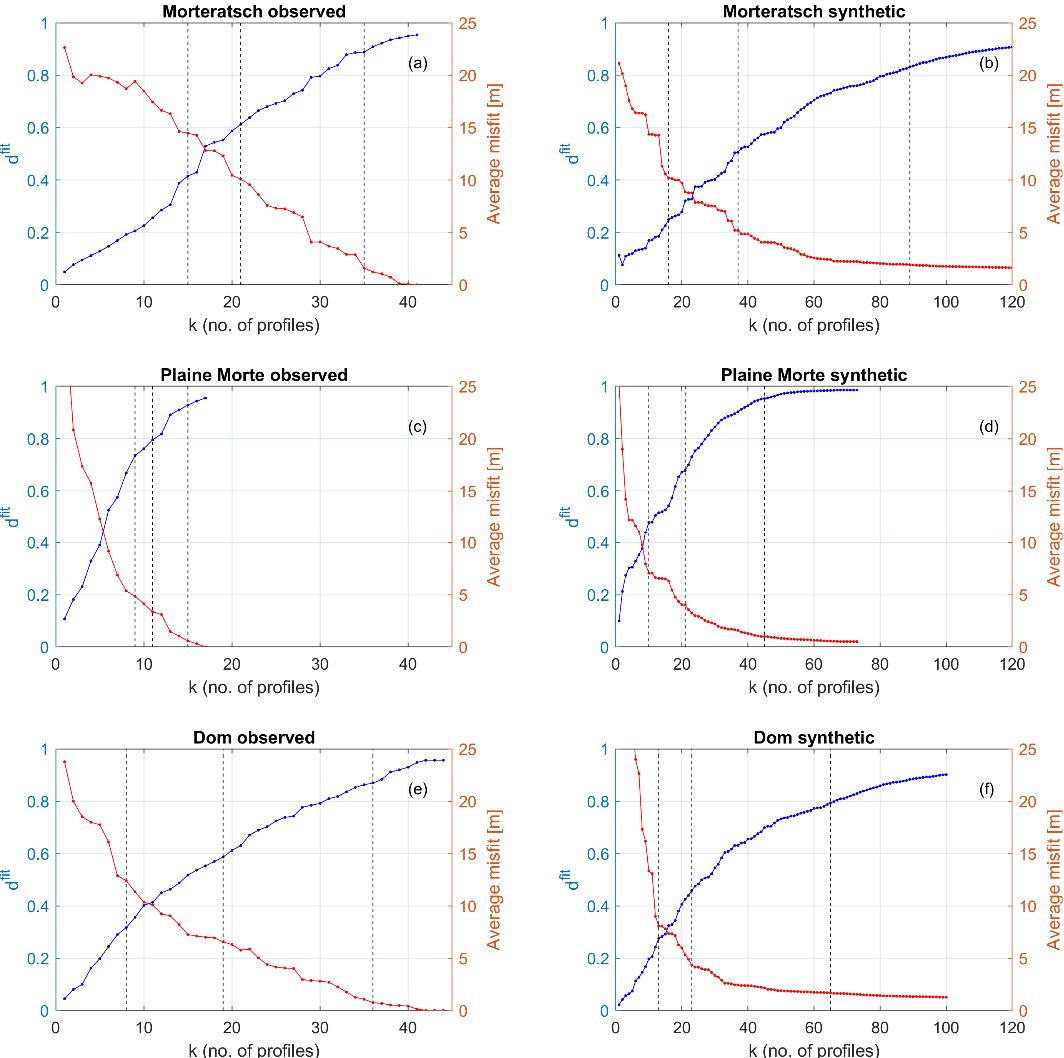
Figure 5. Evolution of data fit d fit (blue curves) and average data misfit mean (cid:0) h est k − h true (cid:1) (red curves). Panels (a) , (c) and (e) show the results for the observed data, and panels (b) , (d) and (f) show the results for the synthetic data generated on a densely spaced grid of hypothetical profiles. Vertical dashed lines indicate the number of profiles required to achieve d fit values of 0.5, 0.7 and 0.9 (see also Figs. 6 to